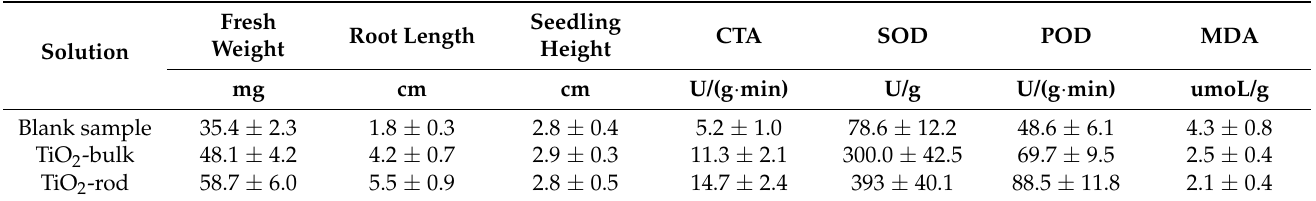
Table 1. Fresh weight, root length, seedling height, CAT, SOD, POD activity and MDA content of germinated camphor seedlings soaked with bulk TiO 2 and rod TiO 2